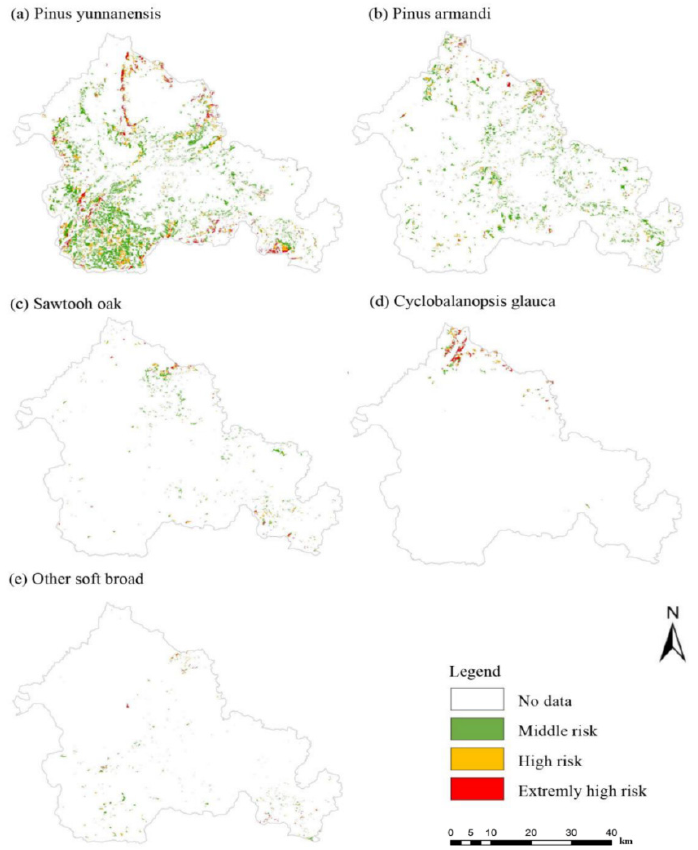
Figure 14. Spatial distribution map of landslide susceptibility of dominant tree species in Weining County.